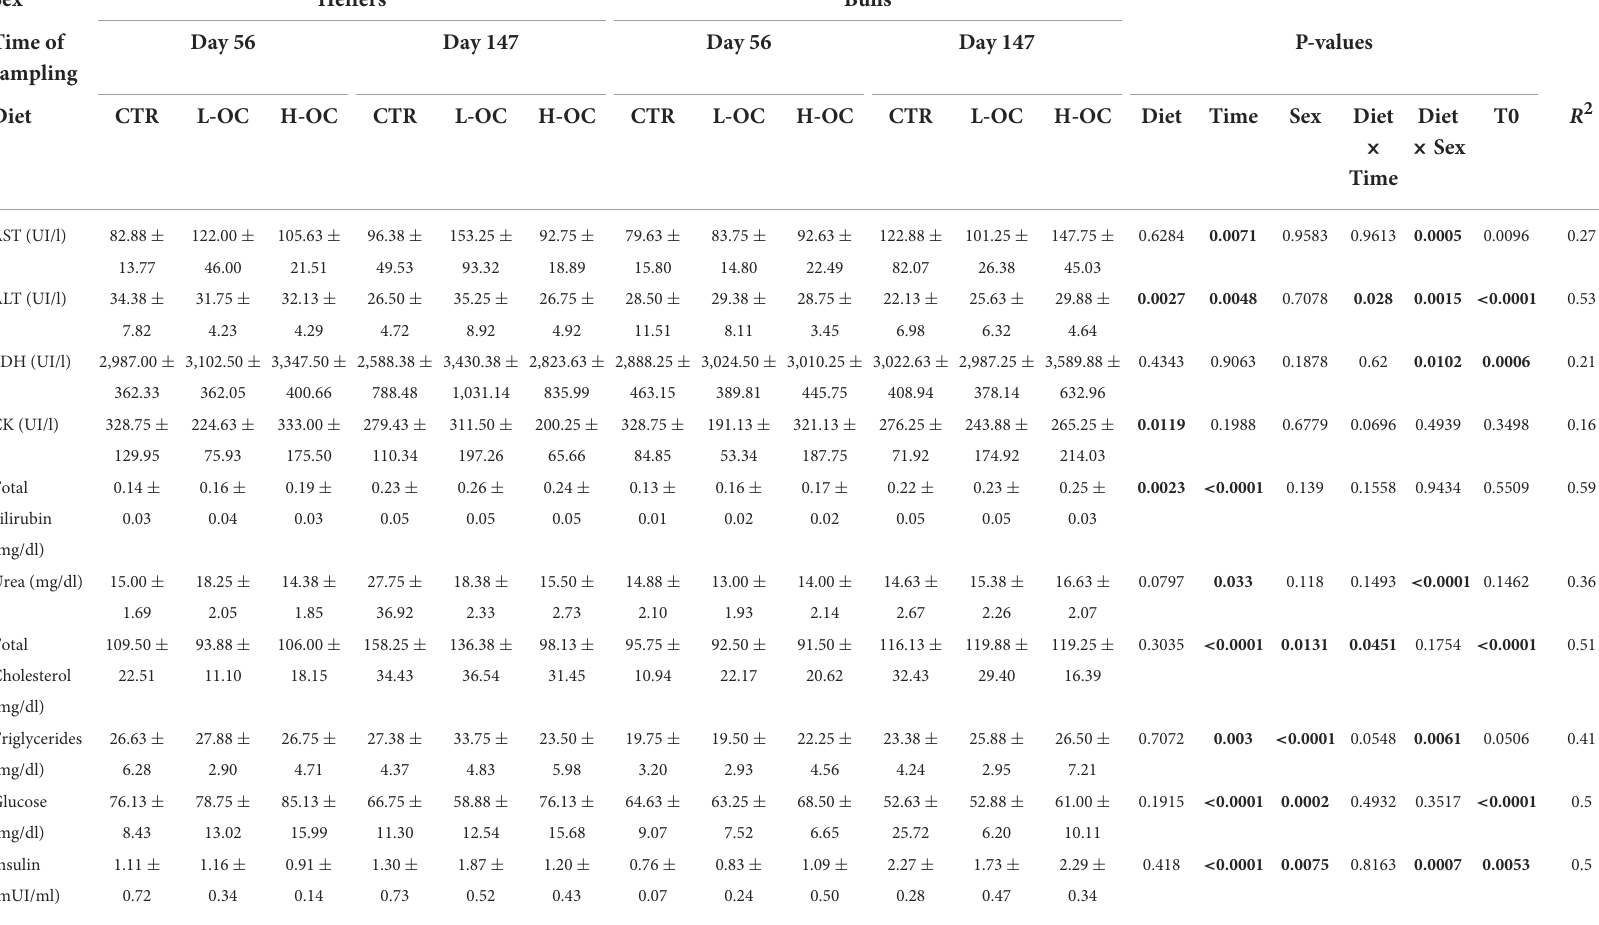
TABLE 3 Mean and standard deviation of all the blood analyte measurements, and P -values (in bold when significant) and R 2 of the applied model. Sex Time